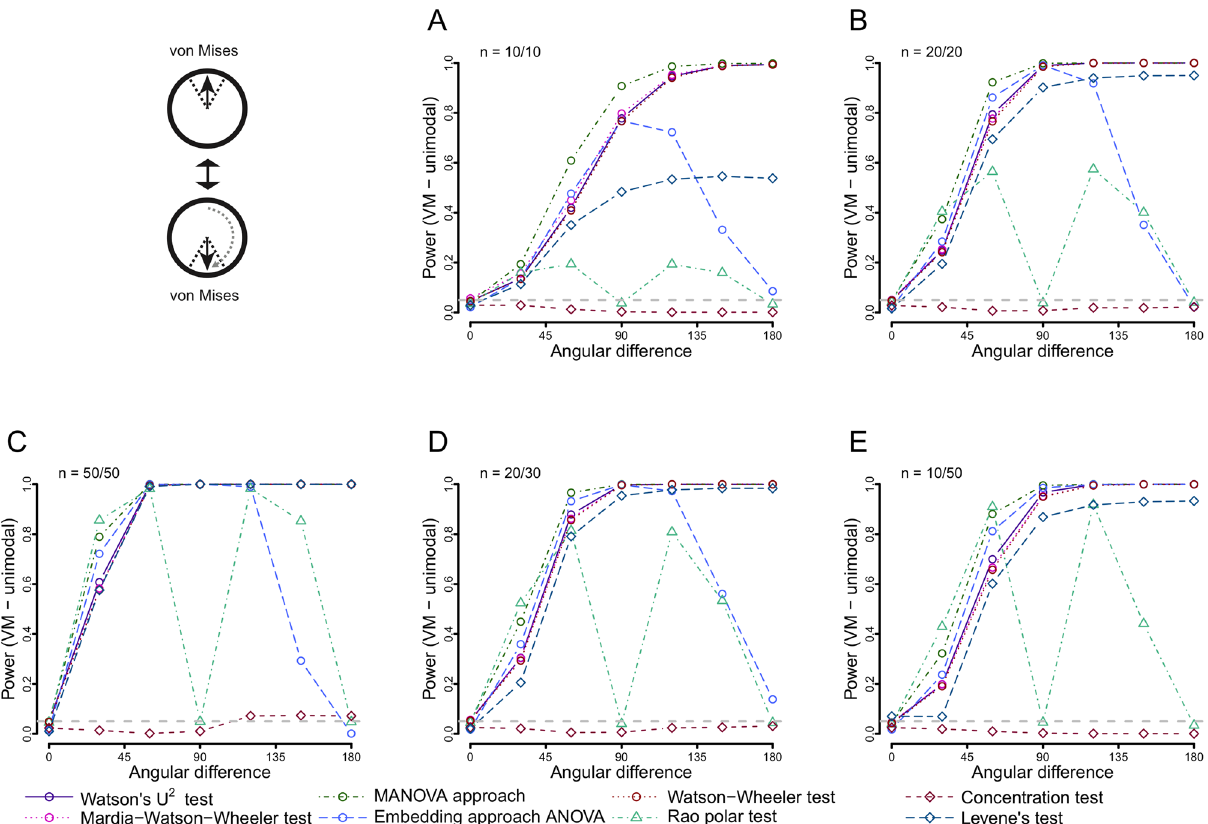
Figure 4. Power of all included tests when comparing von Mises distributions (kappa for both = 2) of differing directions using different sample sizes: 10 and 10 ( A ), 20 and 20 ( B ), 50 and 50 ( C ), 20 and 30 ( D ) and 10 and 50 ( E ). The first distribution is fixed at 0°, the second increases from 0° towards 180.